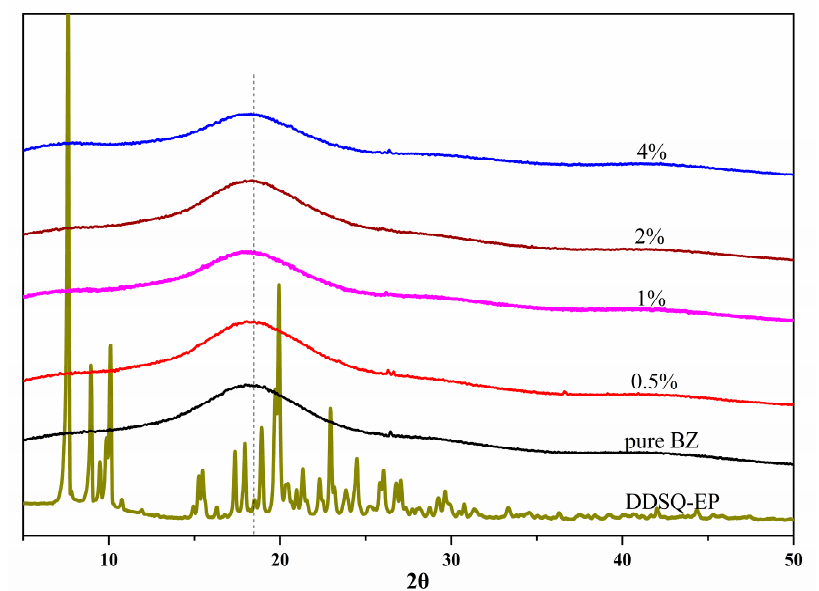
Figure 11. XRD curves of BZ/DDSQ-EP mixture.